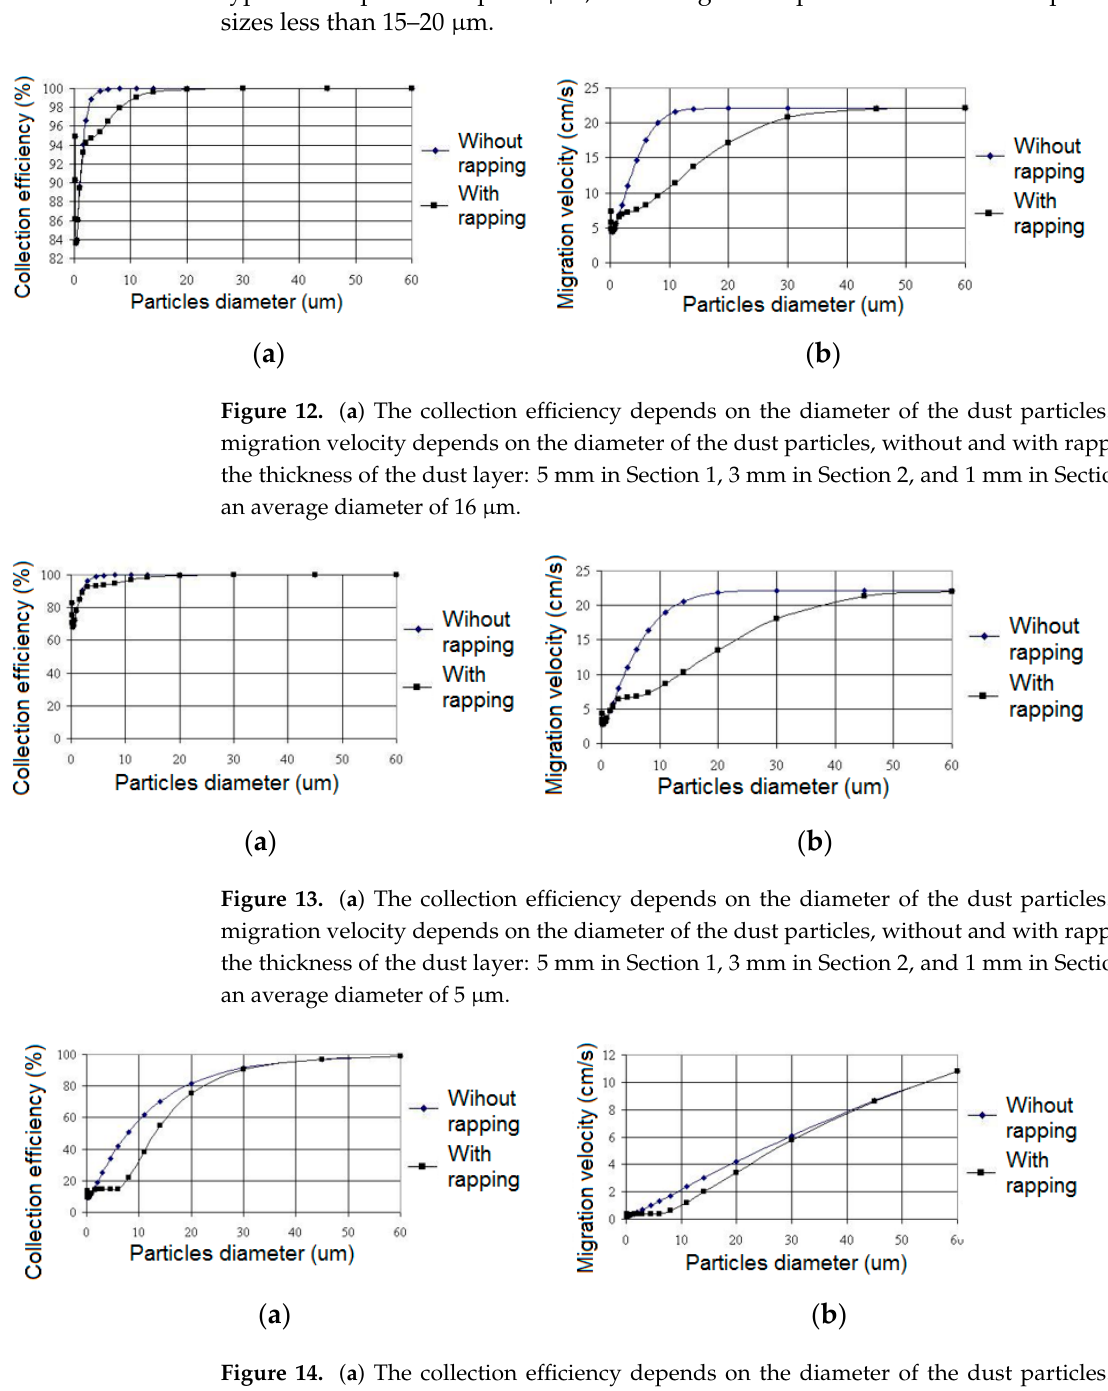
collection efficiency decreases under in all conditions. Collection efficiency is reduced for typical dust particles up to 5 µ m, while migration speed is lower for dust particles with sizes less than 15–20 µ m.